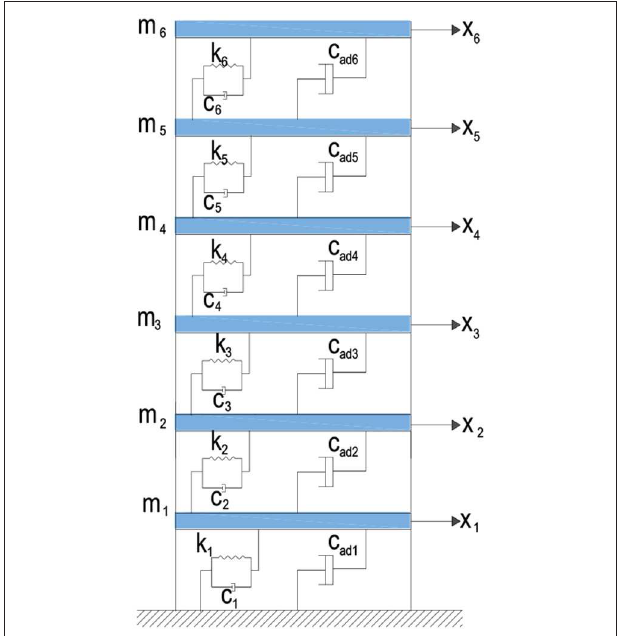
FIGURE 3 | Six story shear building model.